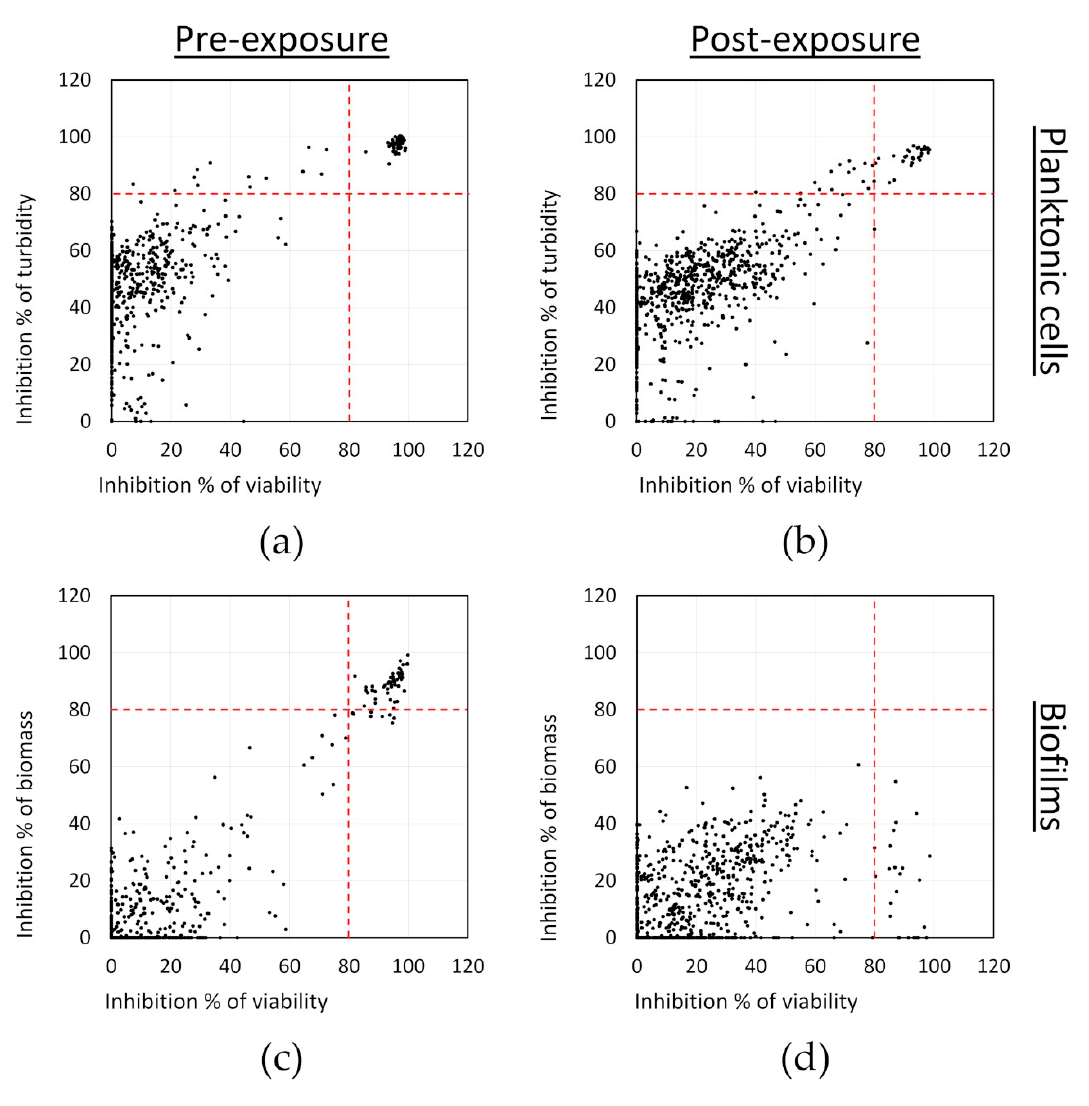
Figure 1. Screening of an FDA-approved compound library against S. aureus in pre-exposure ( a and c panels) and in post-exposure ( b and d panels): ( a , b ) inhibition of planktonic cell viability and turbidity; and ( c , d ) inhibition of the biofilm biomass and viability. Results are averages from two separate experiments with each one replicate per